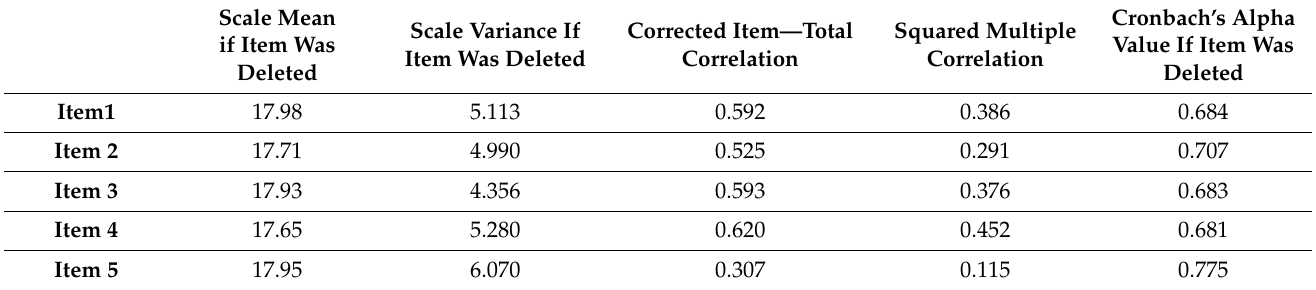
Table 2. Table of item—total scale correlations.